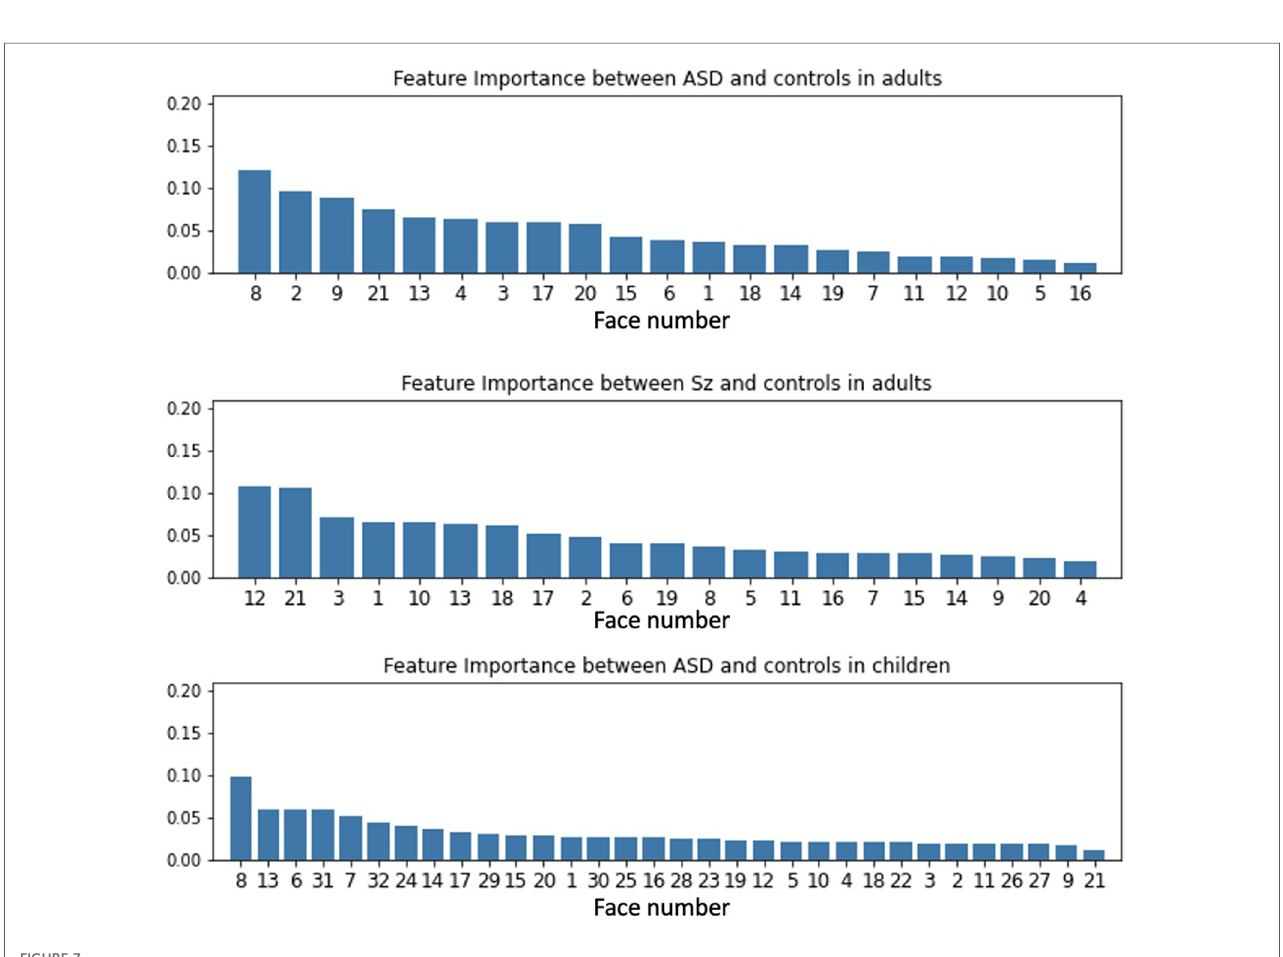
FIGURE 7 Feature importance for each weighted-CNN model.